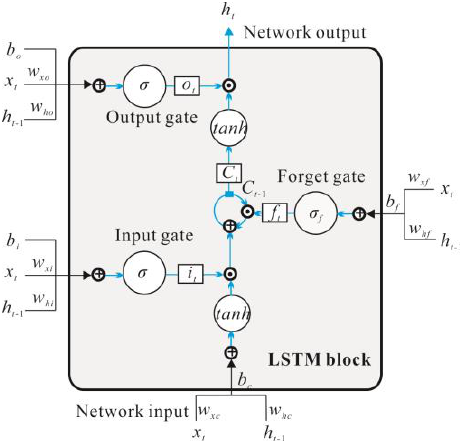
Figure 4. LSTM block structure.